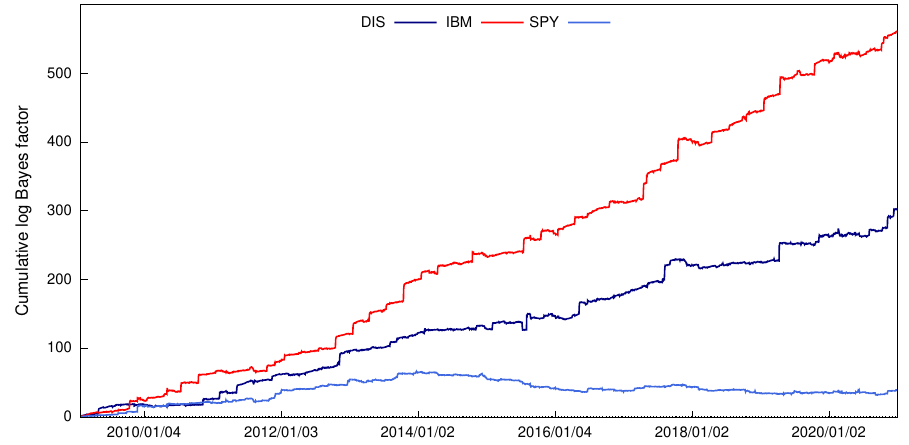
Figure 8. Cumulative log predictive Bayes factors for logRV between RSV-DPM and RSV models T − 1 ∑ log ( p ( log RV t + 1 | y 1: t ,RSV-DPM ) / p ( log RV t + 1 | y 1: t ,RSV )) t = t 0